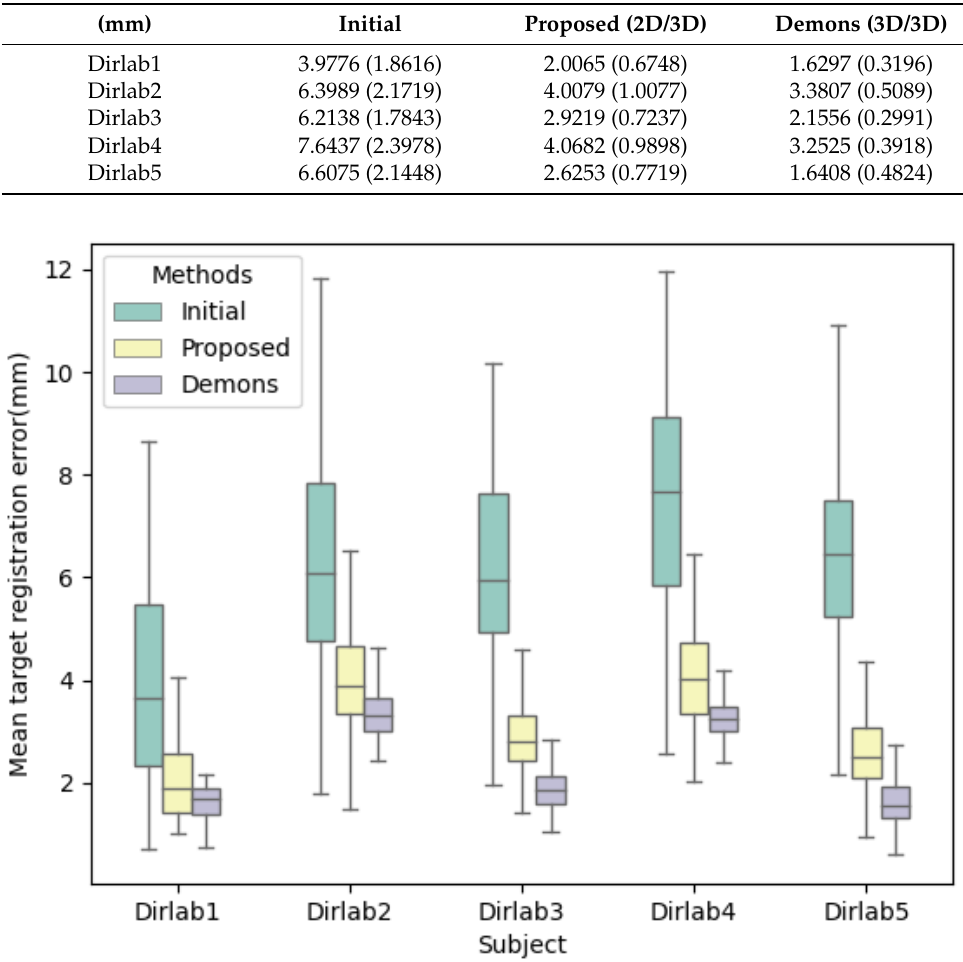
Figure 7. Box plot of landmark points in Dirlab; green indicates the data before registration, yellow is the data after registration of the proposed method, and purple represents the data after 3D/3D registration using